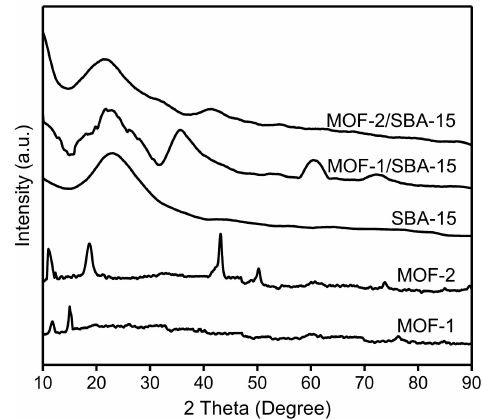
Figure 3. Wide-angle X-ray diffraction (WXRD) patterns of spherical SBA-15, MOF-1, MOF-2, MOF-1/SBA-15 and MOF-2/SBA-15.